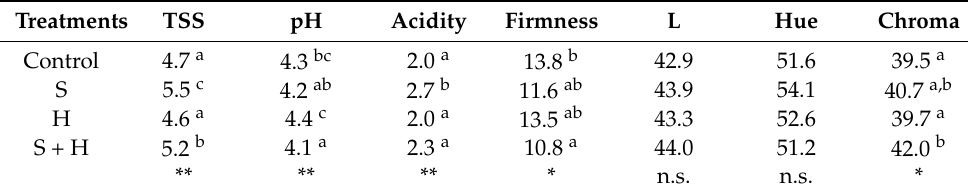
Table 1. Total soluble solids (TSS, ◦ Brix), pH, acidity (g citric acid L − 1 ), firmness (N cm 2 ) and color parameters (L, hue and chroma) of tomato fruits under control (C), saline (S) and heat conditions (H) or the combination of salinity and heat (S + H). Values are means ( n = 6). Treatments TSS pH Acidity Firmness L Hue Chroma Control